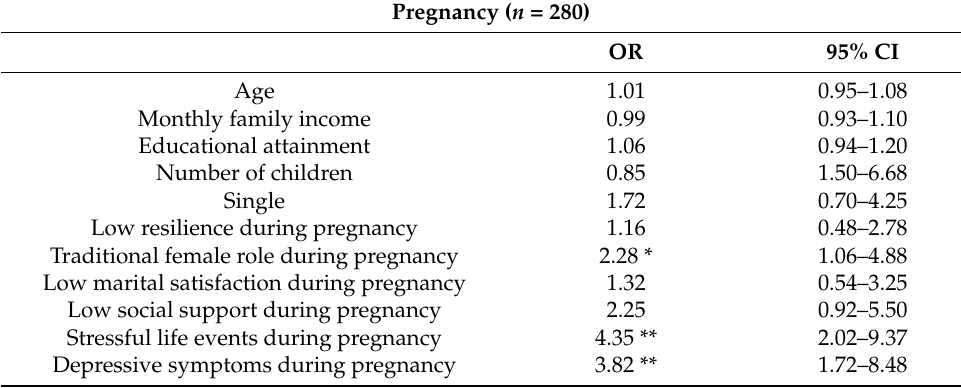
Table 4. Multivariate logistic regression model of anxiety symptoms during pregnancy.